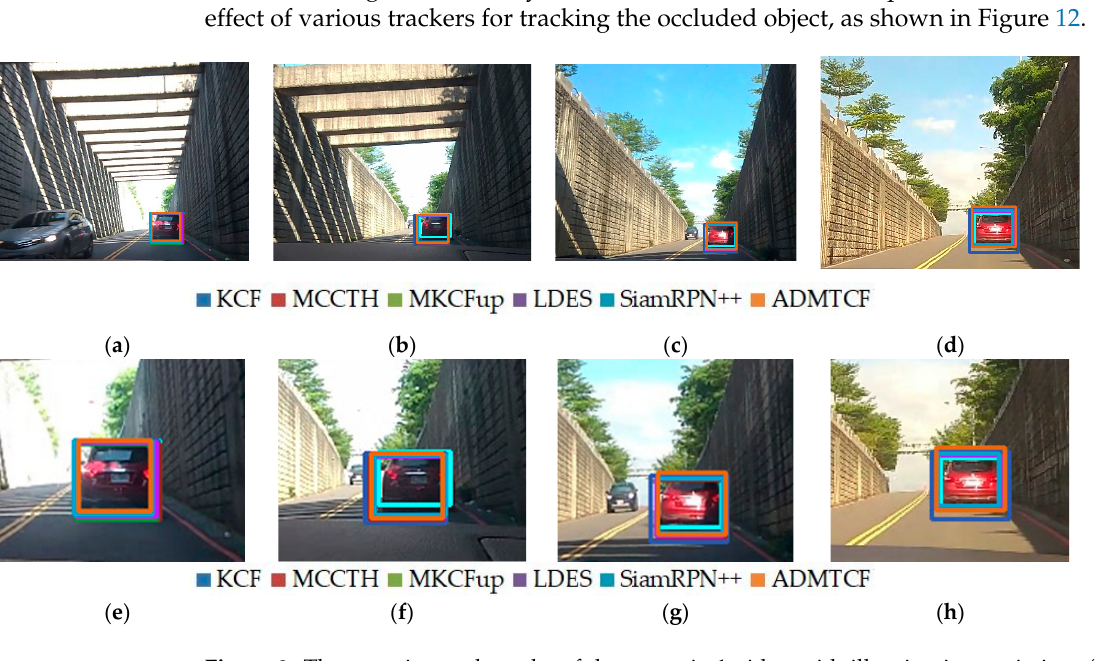
Figure 9. The experimental results of the scenario 1 video with illumination variation: ( a ) the 1st frame of the video; ( b ) the 43rd frame of the video; ( c ) the 71st frame of the video; ( d ) the 126th frame of the video; ( e ) the cropped and enlarged image of image ( a ); ( f ) the cropped and enlarged image of image ( b ); ( g ) the cropped and enlarged image of image ( c ); ( h ) the cropped and enlarged image of image ( d ).